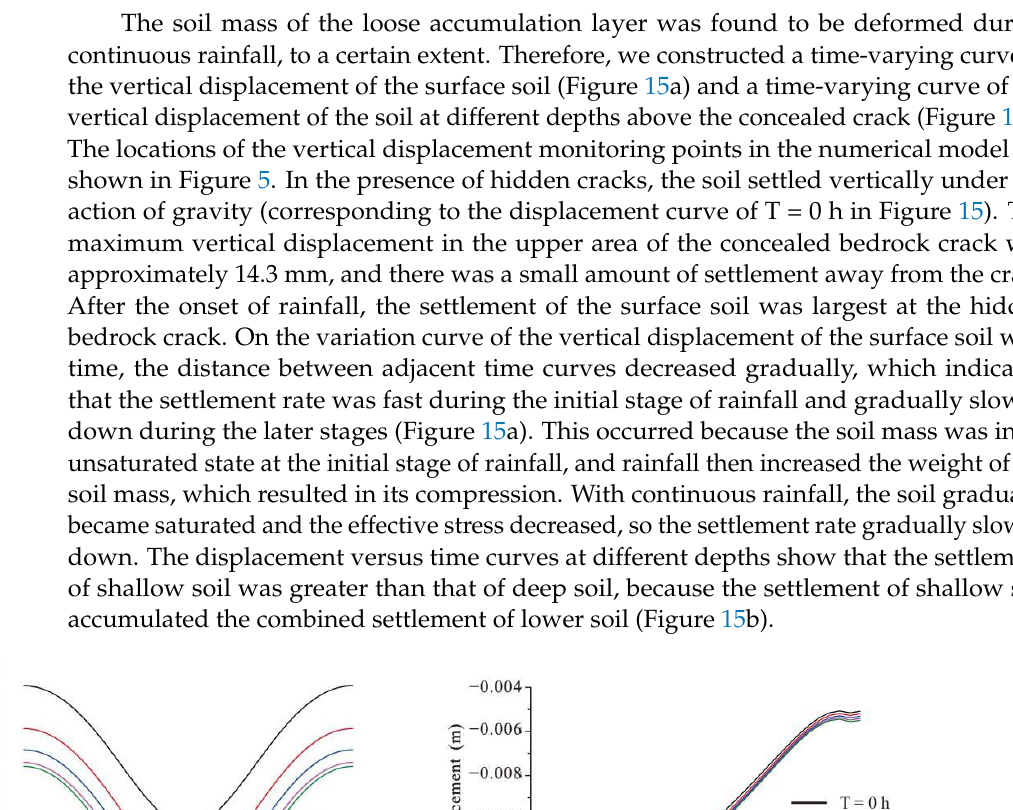
Figure 14. Vertical velocity of seepage. ( a ) Velocity distribution diagram and ( b ) velocity vector diagram, where Flvel is the velocity vector of seepage and Flvel2 is the vertical velocity vector of seepage. The seepage rate is in m/h.